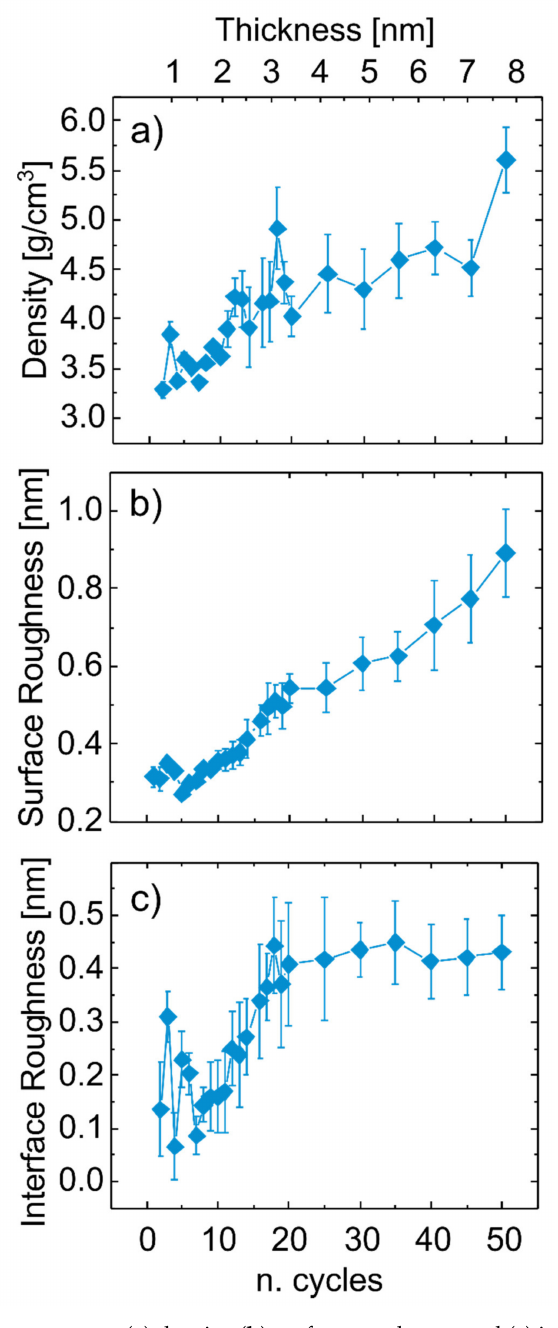
Figure 2. XRR-derived parameters ( a ) density, ( b ) surface roughness, and ( c ) interface roughness as a function of the number of cycles, showing the di ff erent phases of growth. The respective thickness development scale is also